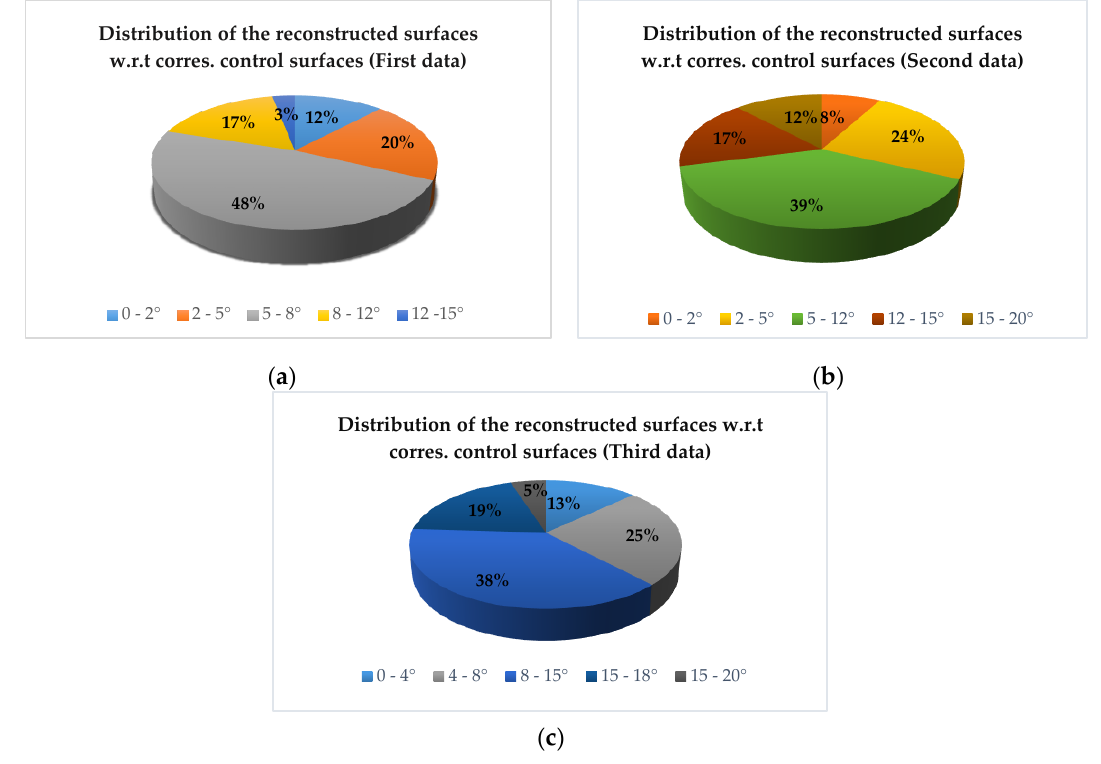
Figure 34. Pie charts representing distribution of the reconstructed surfaces w.r.t to their deviations from corresponding surfaces extracted from overlapping control data sources for the ( a ) first dataset; ( b ) second dataset; and ( c ) third dataset